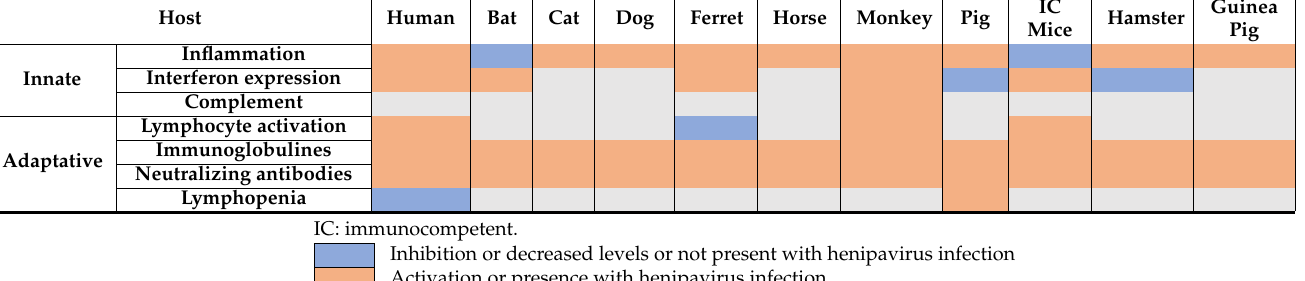
Table 2. Innate and adaptive immune responses during HeV and NiV